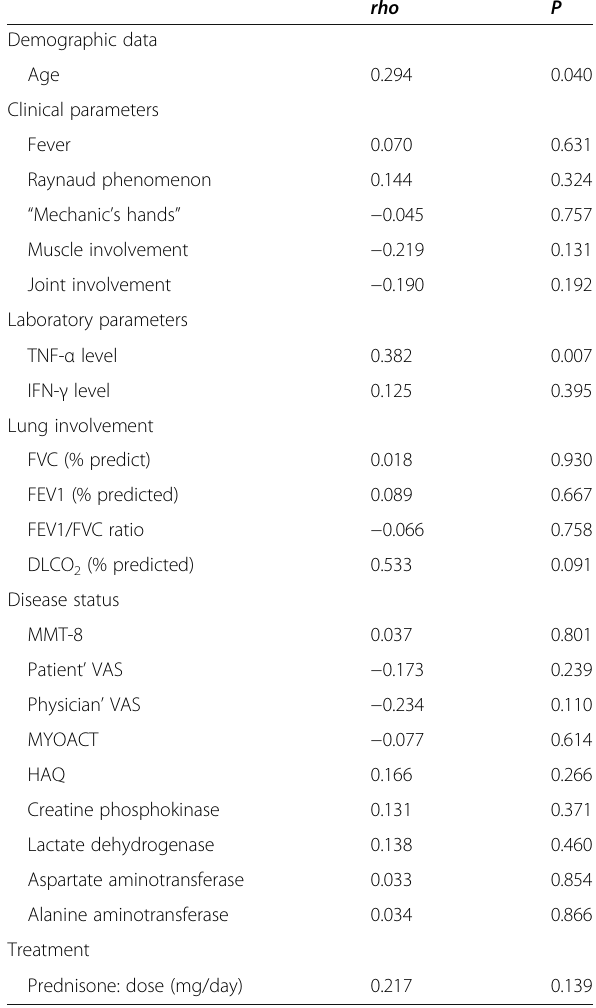
Table 3 Correlation between YKL-40 serum levels and continuous variables (demographic, clinical, laboratory and lung parameters, and disease status) of the patients with antisynthetase